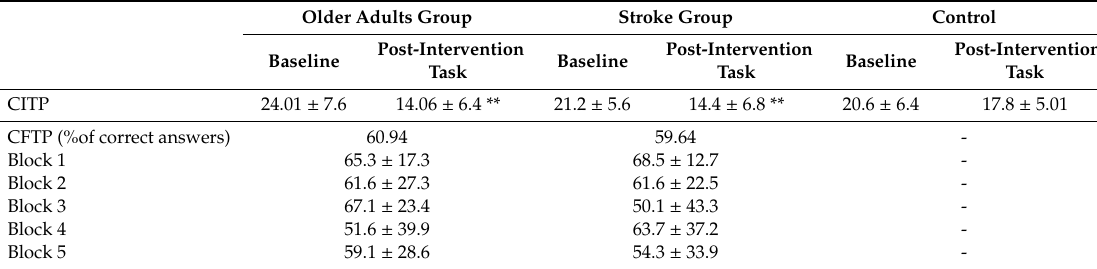
Table 5. Performance in cognitive interference and cognitive fatigue tasks. Older Adults Group Stroke Group Control Post-Intervention Post-Intervention Post-Intervention Baseline Baseline Baseline Task Task